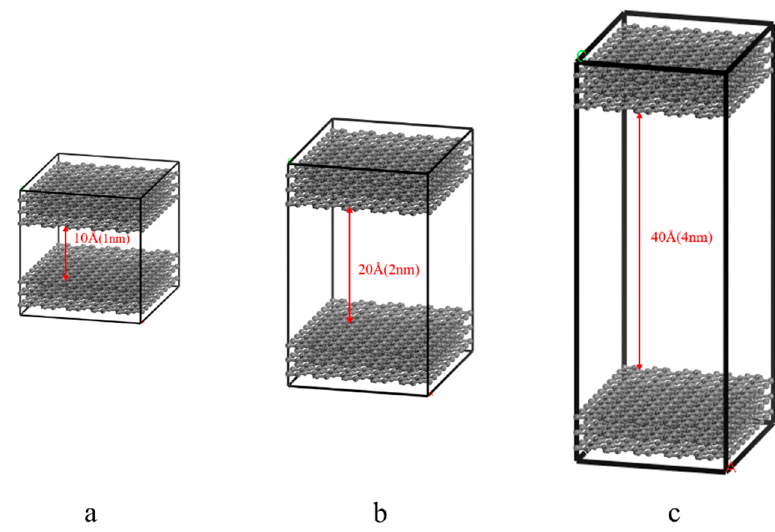
Figure 1. Pore structure model of coal (( a ): 1 nm; ( b ): 2 nm; ( c ): 4 nm).